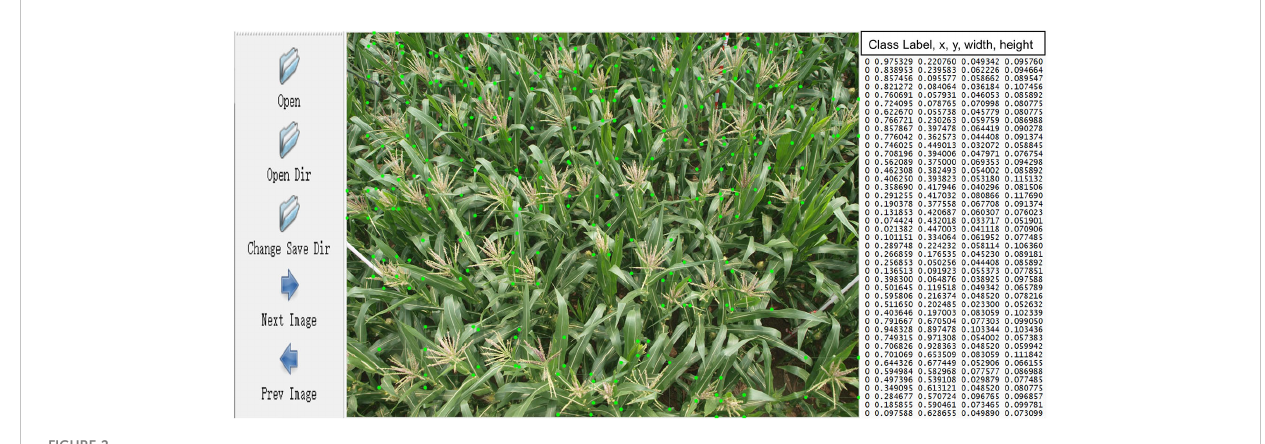
FIGURE 2 Box-level labeling for MrMT dataset.